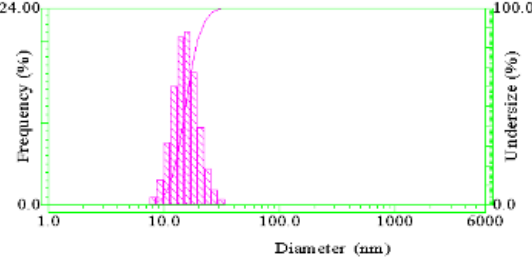
Fig. 1. The particle size distribution of the ZnO/SnO2 photocatalysts nanoparticles.